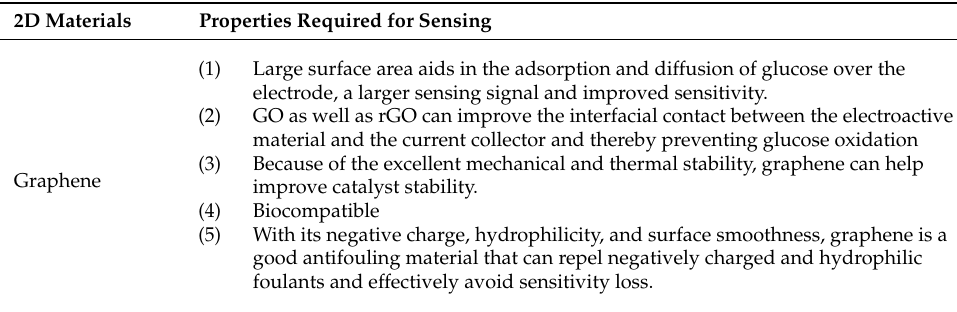
Table 3. Properties of 2D materials required for